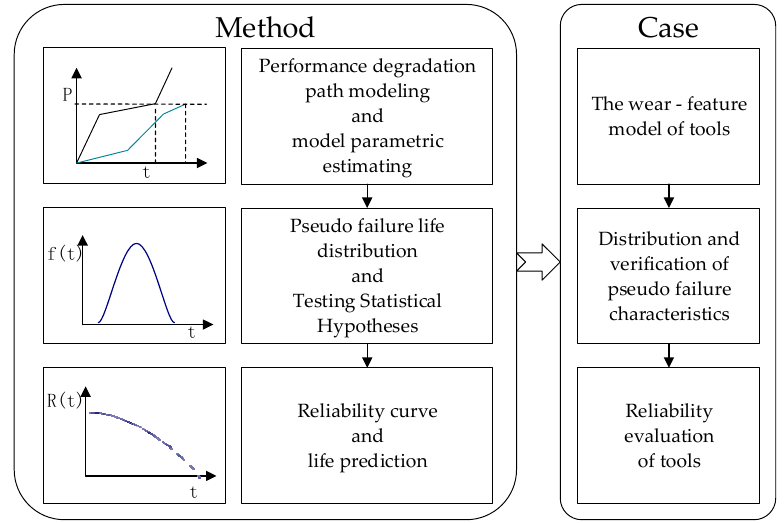
Figure 1. The flowchart of the method.